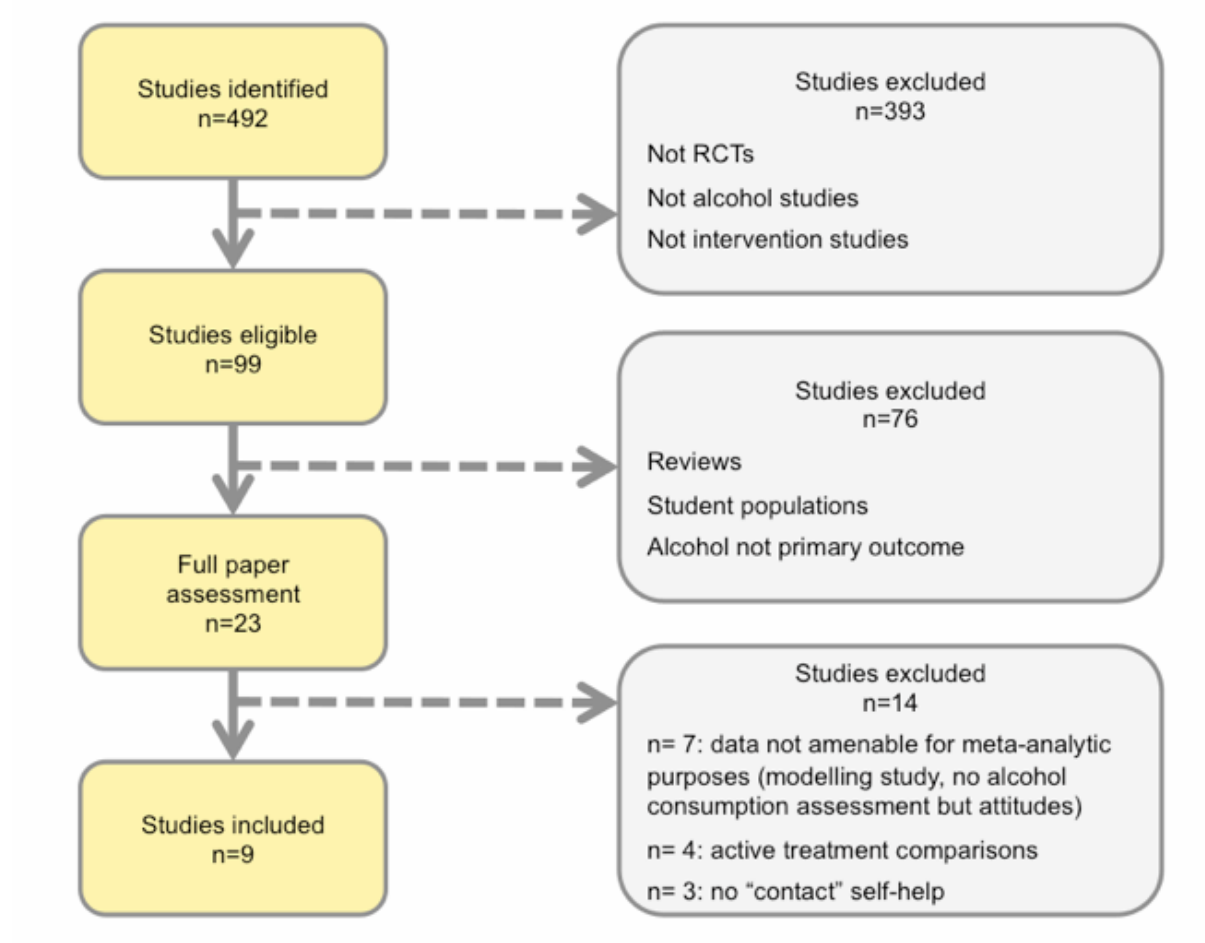
Figure 1. Flow chart of study selection resulting in inclusion of 9 studies and 9